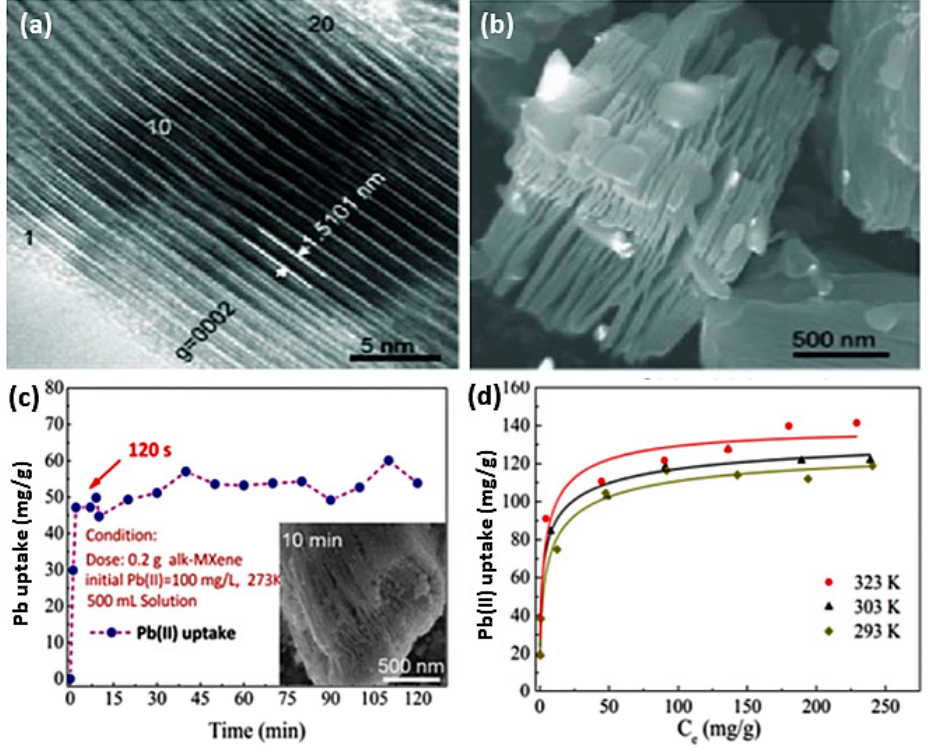
Figure 2. ( a ) SEM graph of alk-MXene after 10 h of exfoliation (HF solution). ( b ) HRTEM micrograph of alk-MXene. ( c ) Kinetics tests and SEM morphology of lead sorption. ( d ) Temperature-dependent lead sorption isotherms onto alk-MXene. Adapted and reproduced with permission from [48]. Copyright 2014